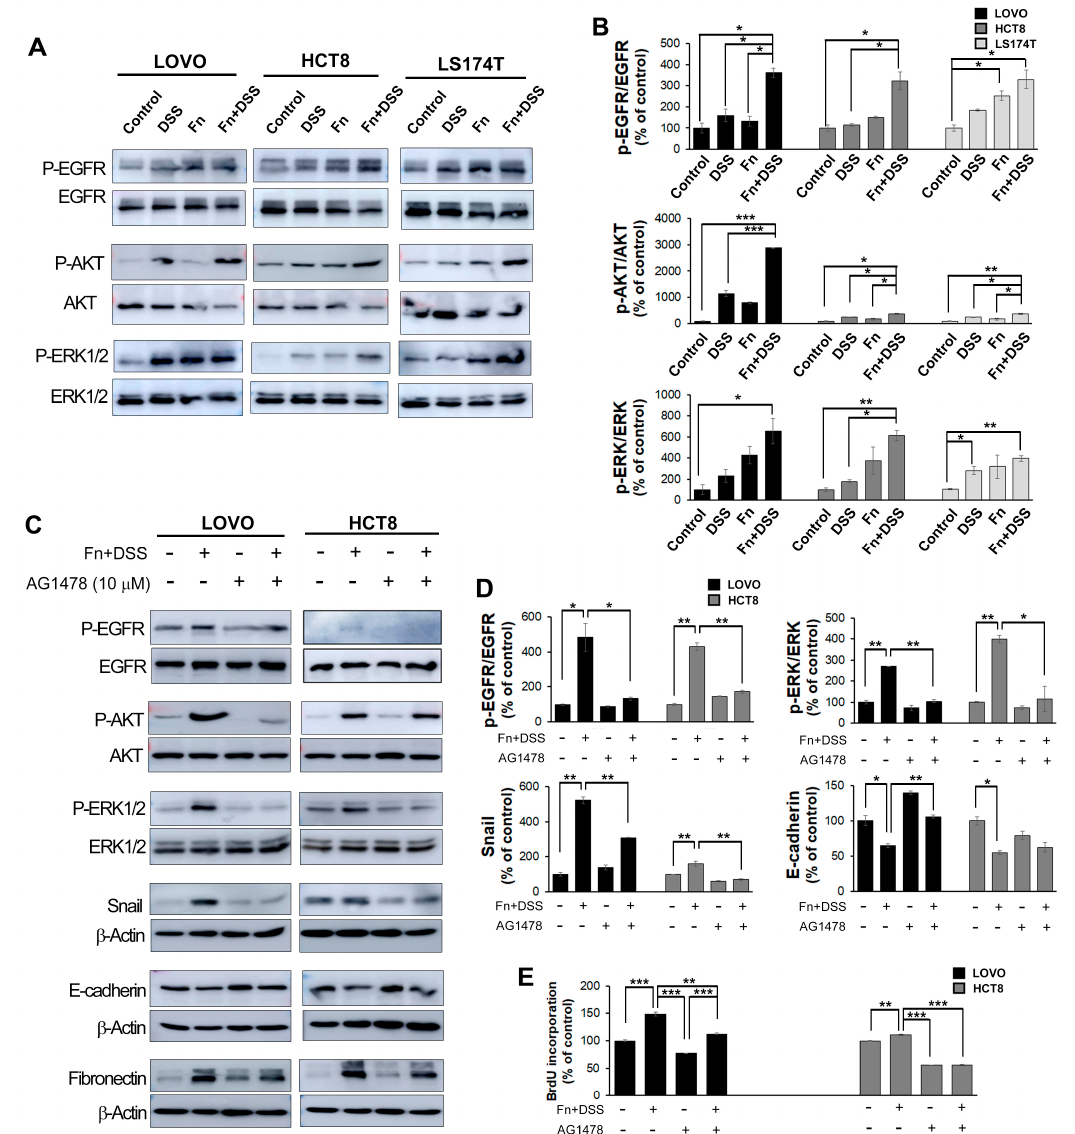
Figure 7. F. nucleatum promotes EMT through the EGFR signaling pathway. ( A ) The expression of EGFR pathway-related markers in CRC cells co-cultured with vehicle, DSS, F. nucleatum , or F. nucleatum + DSS was analyzed using Western blotting. Uncropped Western Blot Figures are available in Figure S8. ( B ) Quantitation of ( A ). Band intensities of each target protein were measured using an image analyzer and expressed as relative ratios. Data are the mean ± SEM. * p < 0.05 and *** p < 0.005 vs. corresponding controls. ( C ) The expression of EGFR pathway-related markers and EMT-related markers in CRC cells with or without AG1478 was analyzed using Western blotting. Uncropped Western Blot Figures are available in Figure S9. ( D ) Quantitation of ( C ). The band intensities of each target protein were measured using Image J software (ImageJ bundled with 64-bit Java 1.8.0_172, web site: https: // imagej.nih.gov / ij / index.html) and expressed as relative ratios. ( E ) The graph represents relative protein levels obtained from three independent experiments. Densitometry of blots was followed by the calculation of relative protein levels compared with the control after normalization to beta-actin levels. Data are the mean ± SEM. * p < 0.05, ** p < 0.01 and *** p < 0.005 vs. corresponding